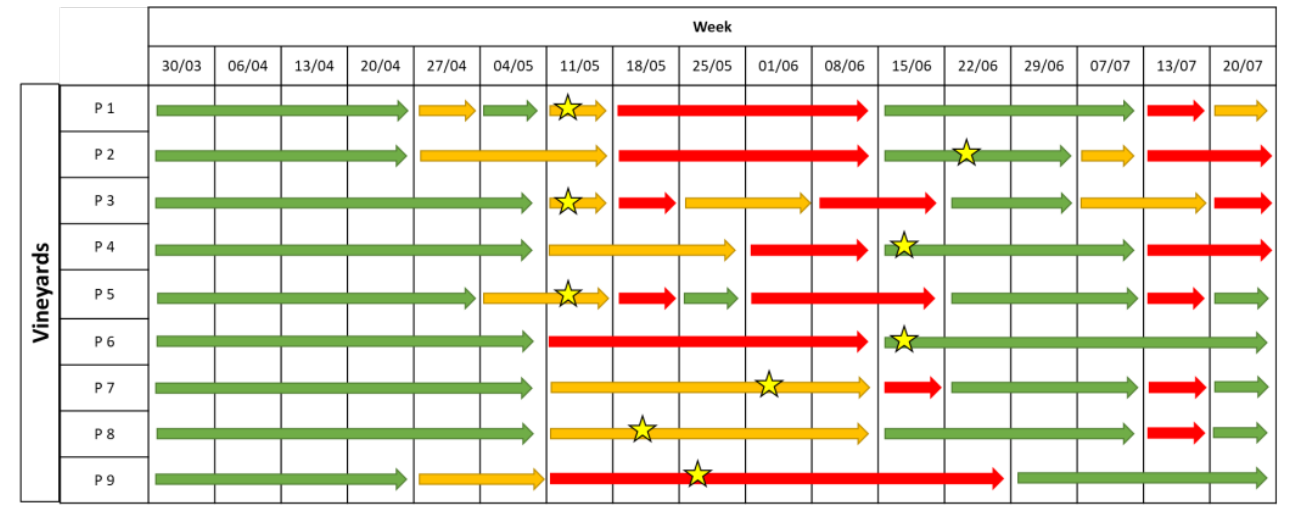
Figure 4. Levels of infection risk signalled by the EPI model. Coloured arrows indicate different levels of infection risk: red indicates a high infection risk, yellow indicates a medium infection risk, and green indicates a low infection risk. The stars indicate the moments when the first symptoms appeared in the field.